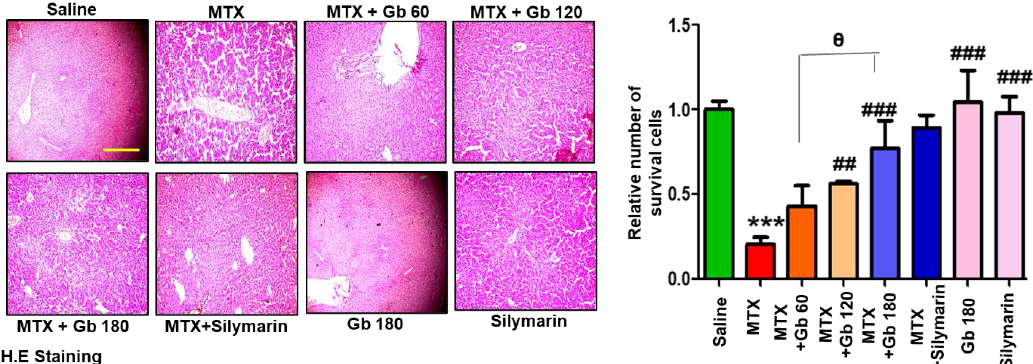
Figure 2. Gb restored the morphological integrity of the liver, as shown by histological examination.